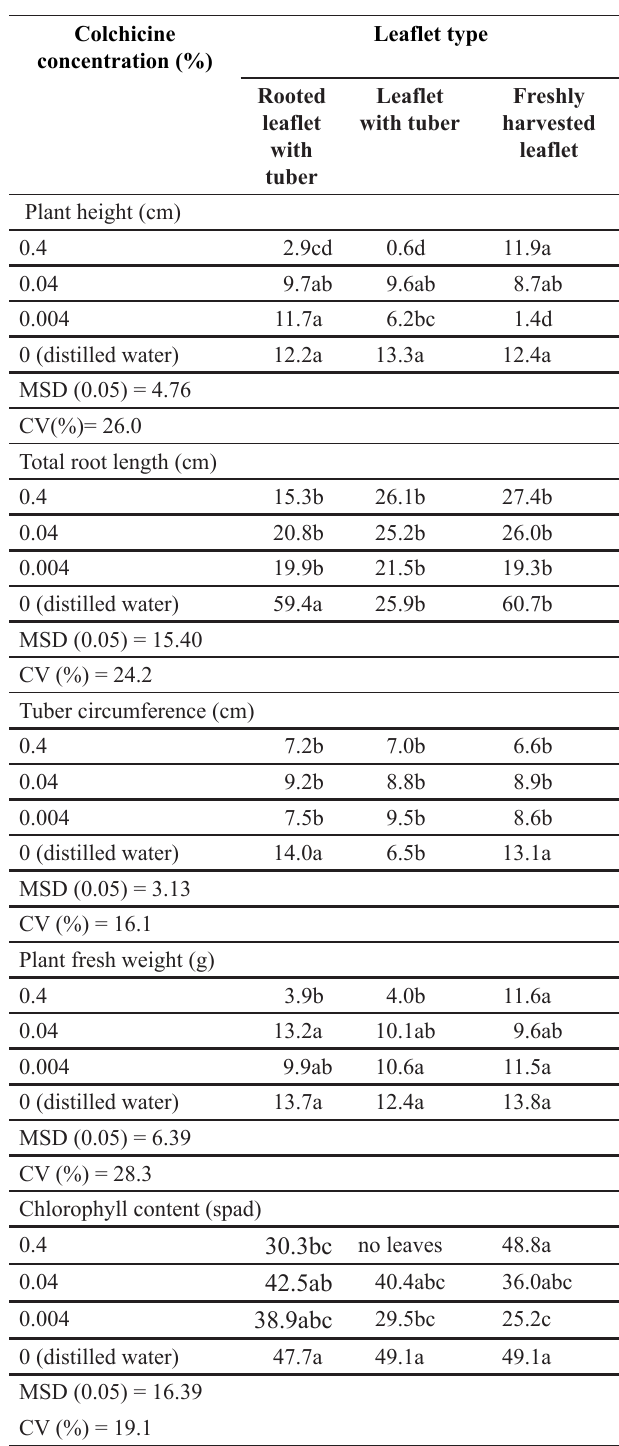
Table 1: Plant parameters of Z. zamiifolia when different leaflet types were treated with different concentrations of colchicine for 24 hours in the first generation (m v 1 1